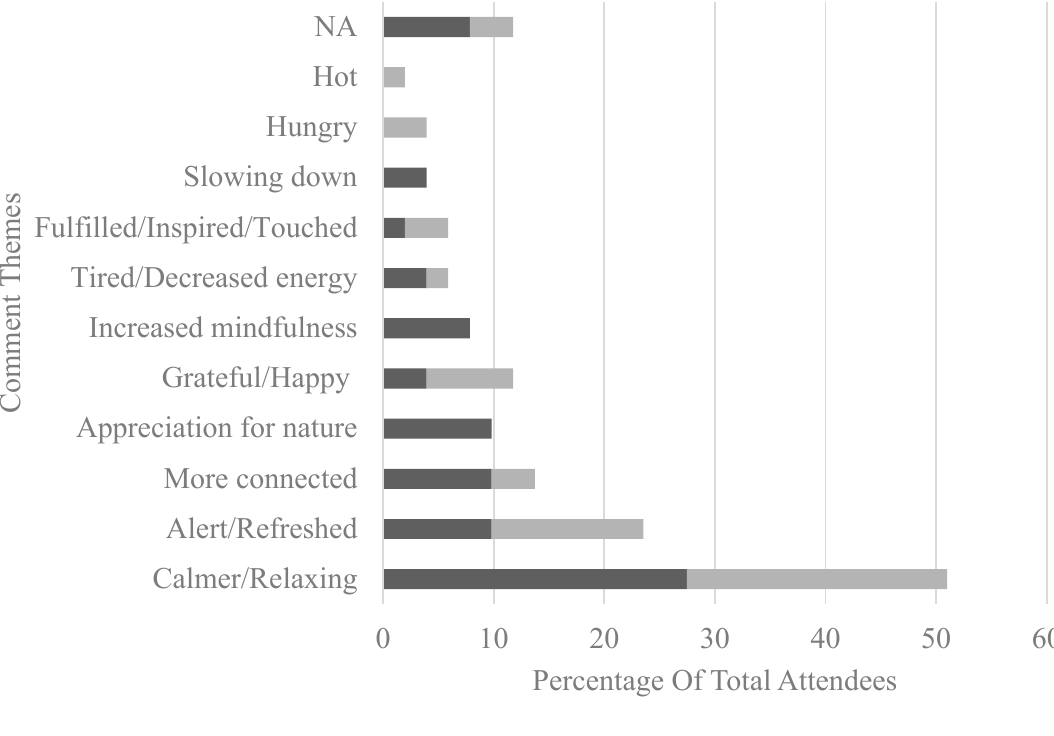
Figure 5. Changes that participants reported feeling after the nature immersion experience. Not all participants responded to open-ended items, so percentages do not represent the entire sample.